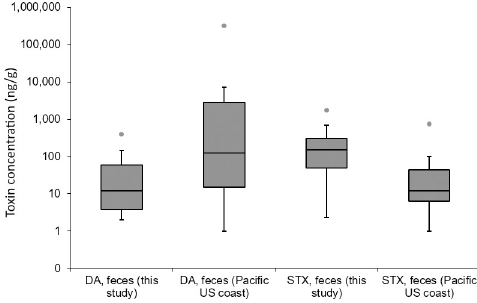
Fig 9. Domoic acid and saxitoxin fecal concentrations (ng/g) detected in this study vs. previously reported values in Pacific U.S. marine mammals. Box lines correspond to 25%, 50% and 75% quartiles, whisker lines correspond to 1.5 times the interquartile range, circle markers represent outliers beyond 1.5 times the interquartile range.